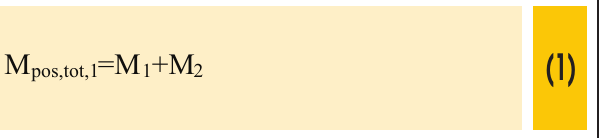
Figure 9 – Bending moment diagram for tests in hollow core slabs with F corresponding to 2 the action of a hydraulic